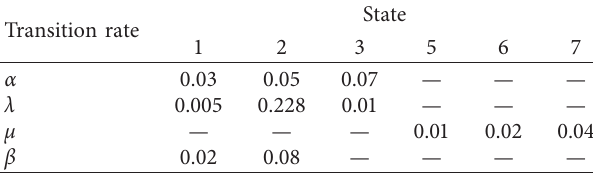
Figure 5: The curves of A ( t ) , D ( t ) , and F ( t ) . Table 1: Results of EOT ( t ) and EDT ( t ) .